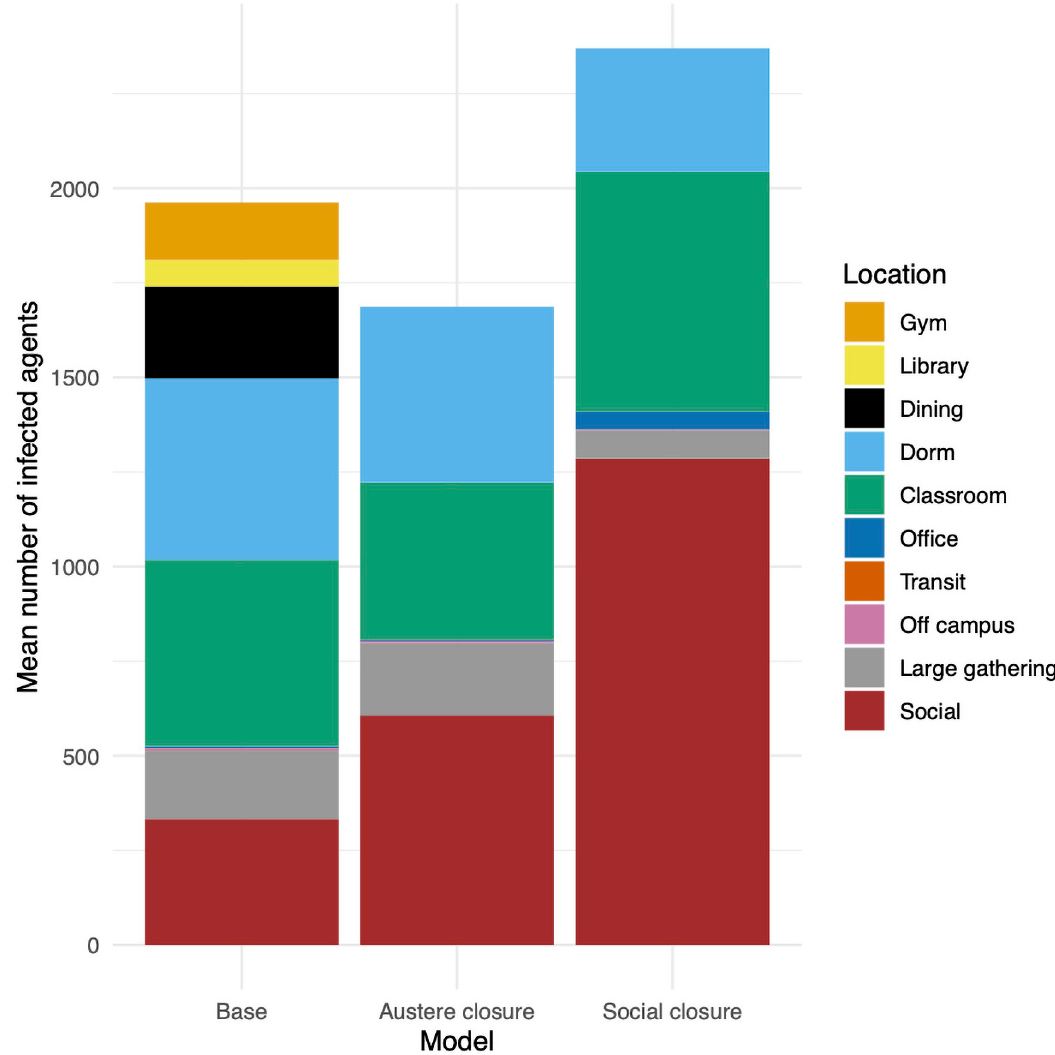
Fig 2. Total infections by room type in the base model and with the gym, library, and dining hall closed. In an “austere closure”, students spend any extra free time alone. In a “social closure”, students spend half of their free time